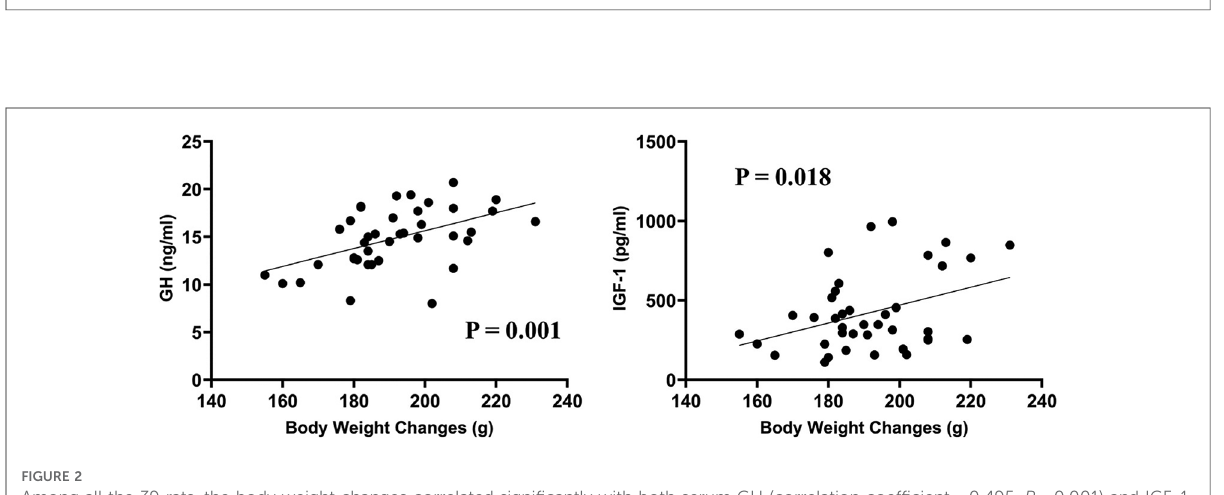
FIGURE 1 Body weight measured at day 30, body weight changes, and serum GH and IGF-1 concentrations detected at day 30 all differed signi fi cantly among the four group of rats in a same trend (all P <0.05): the highest values were all in NC group rats, followed CIH-1 group, CIH-2 group, and CIH-3 group rats.